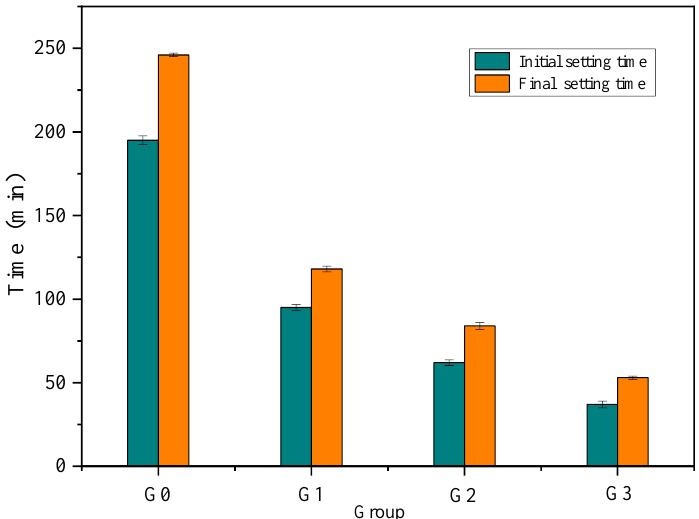
Figure 3. Influence of anhydrite content on the setting time of APC.